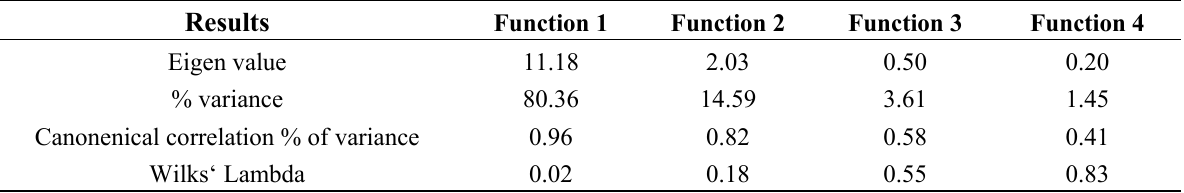
Figure 6. Canonical discriminant functions plot showing different color-coded land use types. Groups 1–5 represent; = Forest; = Urban; = LSHORT; = SSHORT; and = Mixed agriculture land uses respectively. Table 3a. Summary of discriminant function analysis results.